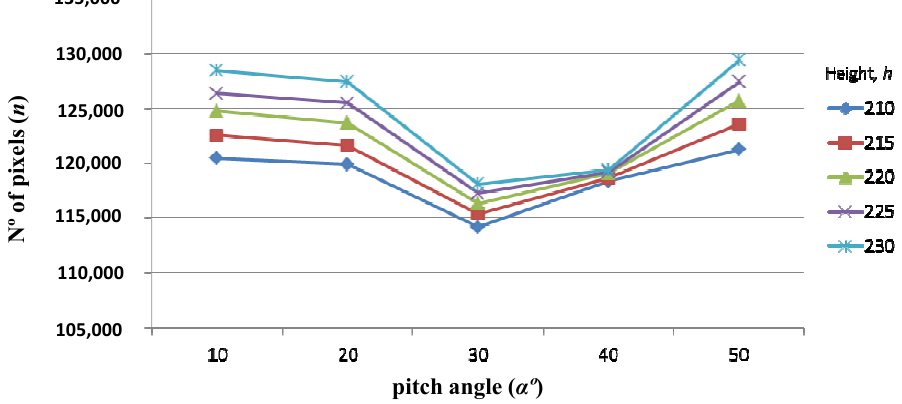
Figure 7. Number of pixels n, against α , for the five different heights h, at a fixed distance d = 3